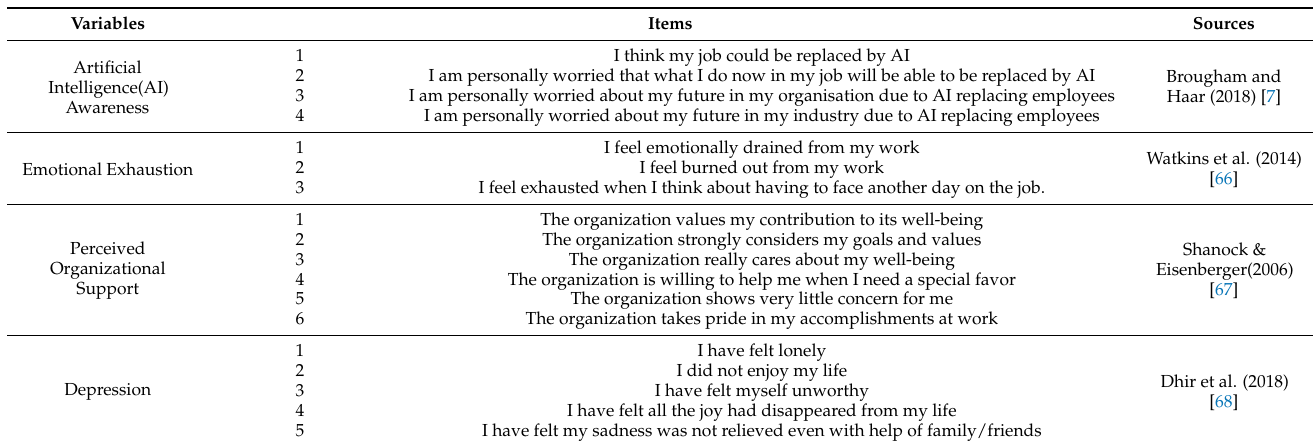
Table A1. Measurement items of key